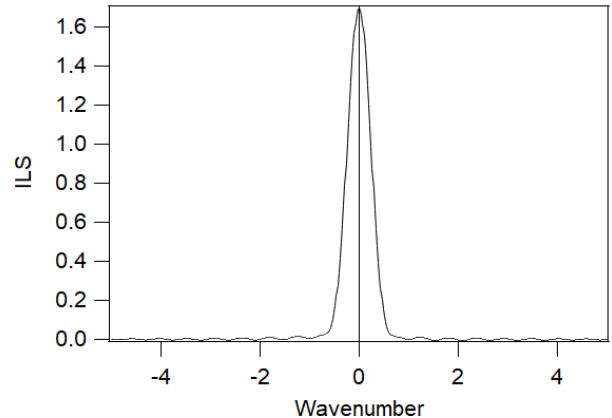
Figure 6. Retrieved instrument line-shape function for the IRcube FTS at nominal 0.55cm − 1 resolution. The measured half width at half height is 0.58cm − 1